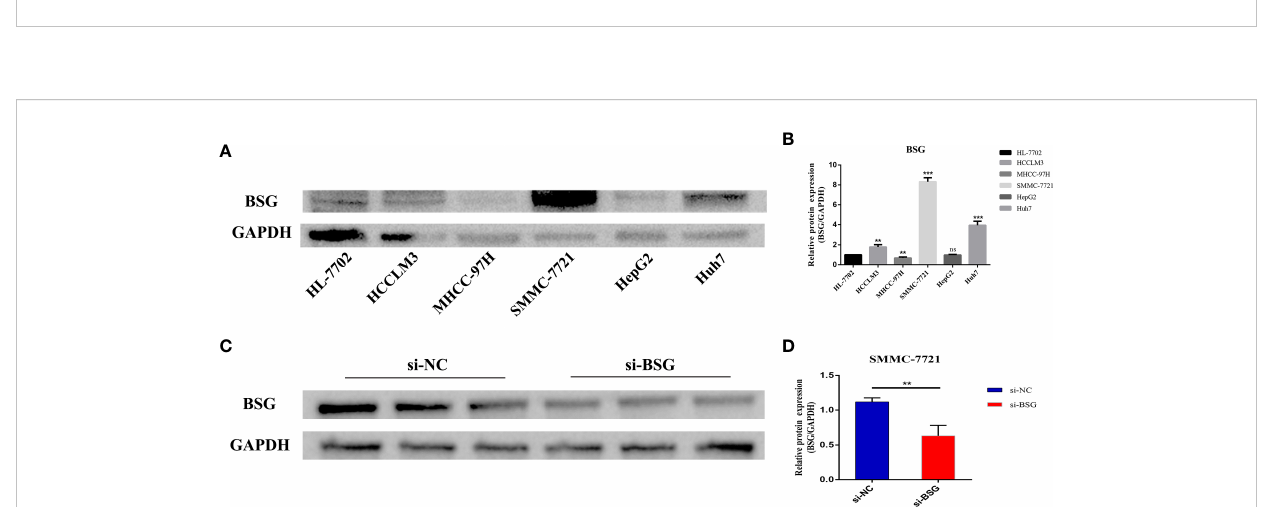
FIGURE 11 Evaluate the expression level of BSG in HCC cell line, and then verify the intervention ef fi ciency. (A) Compared with HL-7702(normal liver cell), BSG is generally highly expressed in tumor cells and has the highest expression in SMMC7721. (B) Differential protein expression of BSG between hepatocytes and hepatoma cells. (C) Veri fi cation of intervention ef fi ciency through western blot. (D) The expression of BSG protein was signi fi cantly reduced in SMMC-7721 cells after the intervention of BSG expression. **P value<0.01; ***P value<0.001; ns, Not Signi fi cant.